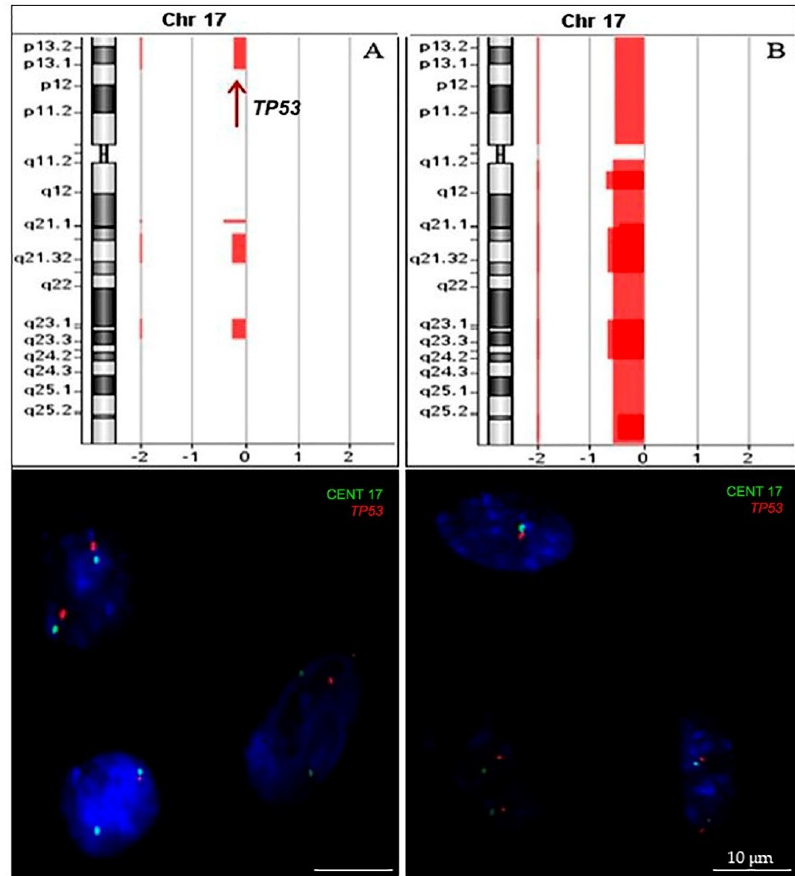
Figure 3. TP53 allelic loss identified by array-comparative genomic hybridization (CGH) (upper line) was confirmed by interphase fluorescence in situ hybridization (iFISH) using LSPs (lower line). Results for two exemplary cases are shown: Image ( A ) shows heterozygous deletion of TP53 gene; image ( B ) shows monosomy of chromosome 17. Scale bars = 10 μm.